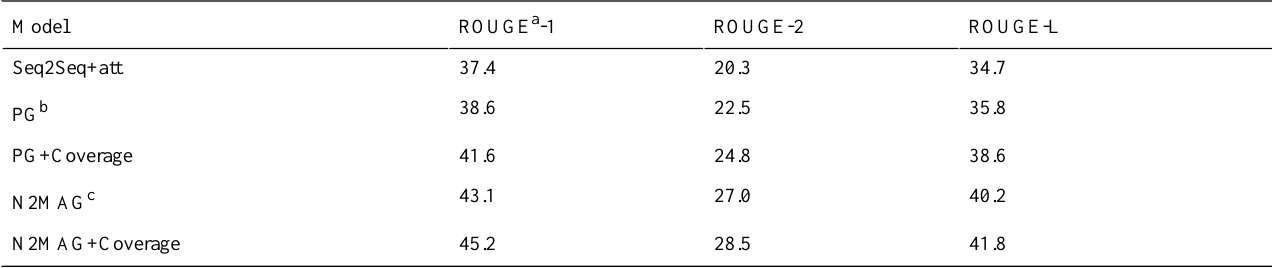
Table 1. Performance results evaluated with the F1 ROUGE scores (%). All scores of N2MAG and N2MAG+Coverage are statistically significant using 95% CIs with respect to competitor models.